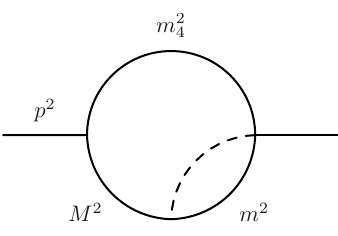
Figure 6 . The diagram for sector 3, namely I ( M 2 ; m 2 ; 0 ; m 2